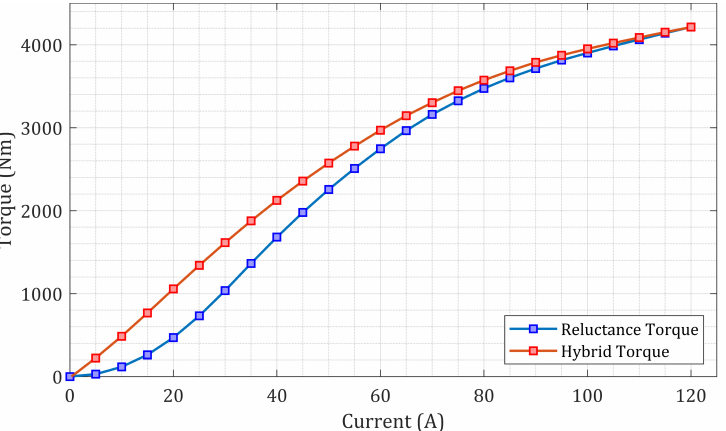
Figure 8. Hybrid and reluctance torque vs. current.